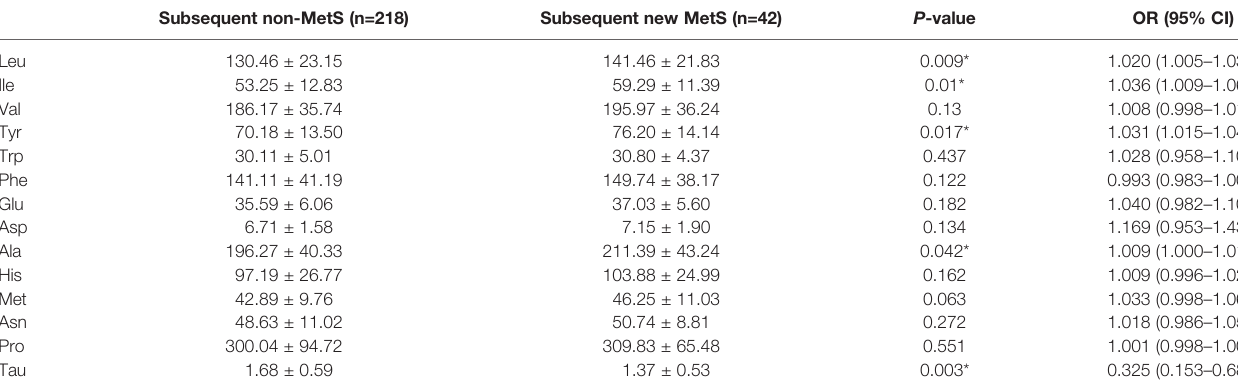
TABLE 7 | The baseline of plasma amino acid concentrations in subsequent new MetS and subsequent non-MetS groups. Subsequent non-MetS